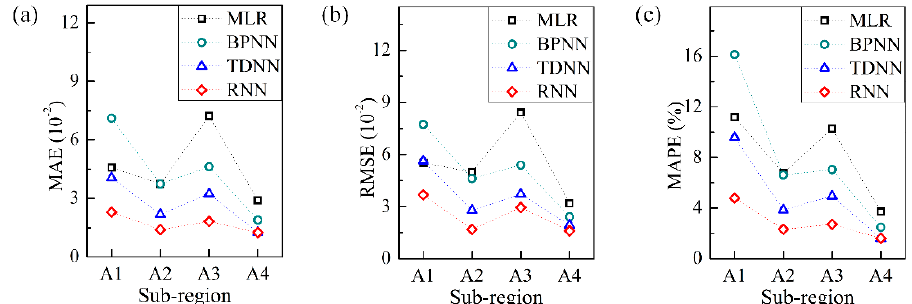
Figure 5. Error parameters ( a ) mean absolute error ( MAE ), ( b ) root mean square error ( RMSE ) and ( c ) mean absolute percentage error ( MAPE ) of the MLR, BPNN, TDNN and RNN models for predicting the NDVI.